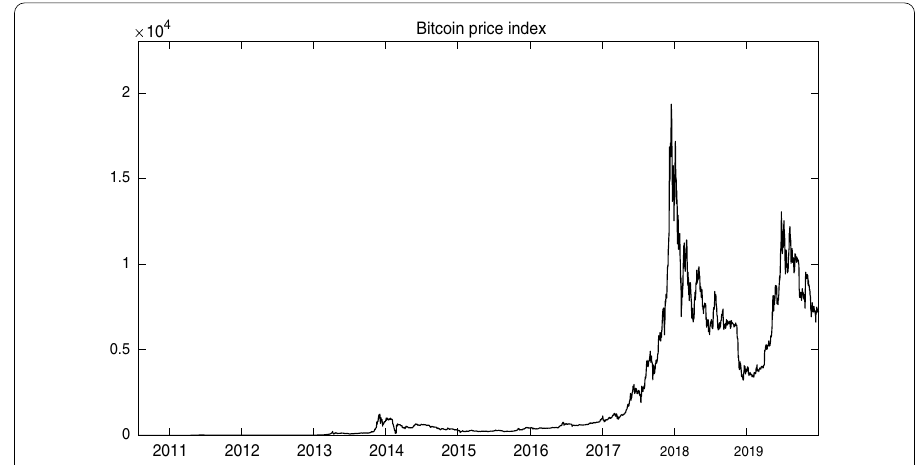
Fig. 1 Bitcoin price index. This figure plots the price of Bitcoin from August 1, 2010 to December 31,